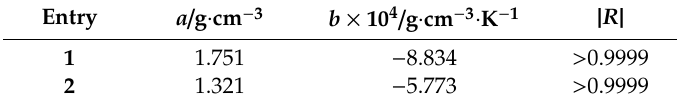
Figure 3. Temperature dependence of density of 1-allyl-1-(oxiran-2-ylmethyl)piperidinium-based ILs ( ● ) 1 and ( ○ ) 2 . Table 2. Fitted parameters for the density of the 1-allyl-1-(oxiran-2-ylmethyl)piperidinium-based ILs.